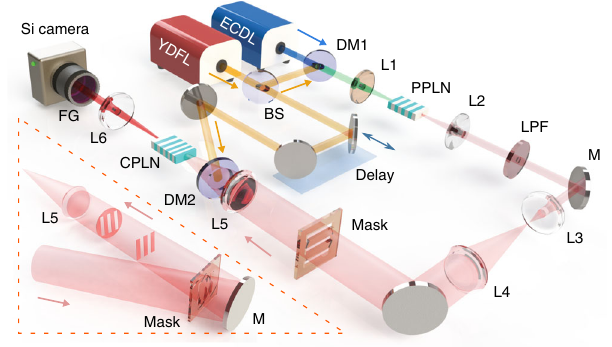
Fig. 3 Experimental setup of the wide- fi eld MIR frequency upconversion imaging. The laser sources are from an ytterbium-doped fi ber laser (YDFL) and a tunable extended cavity diode laser (ECDL) at the telecom